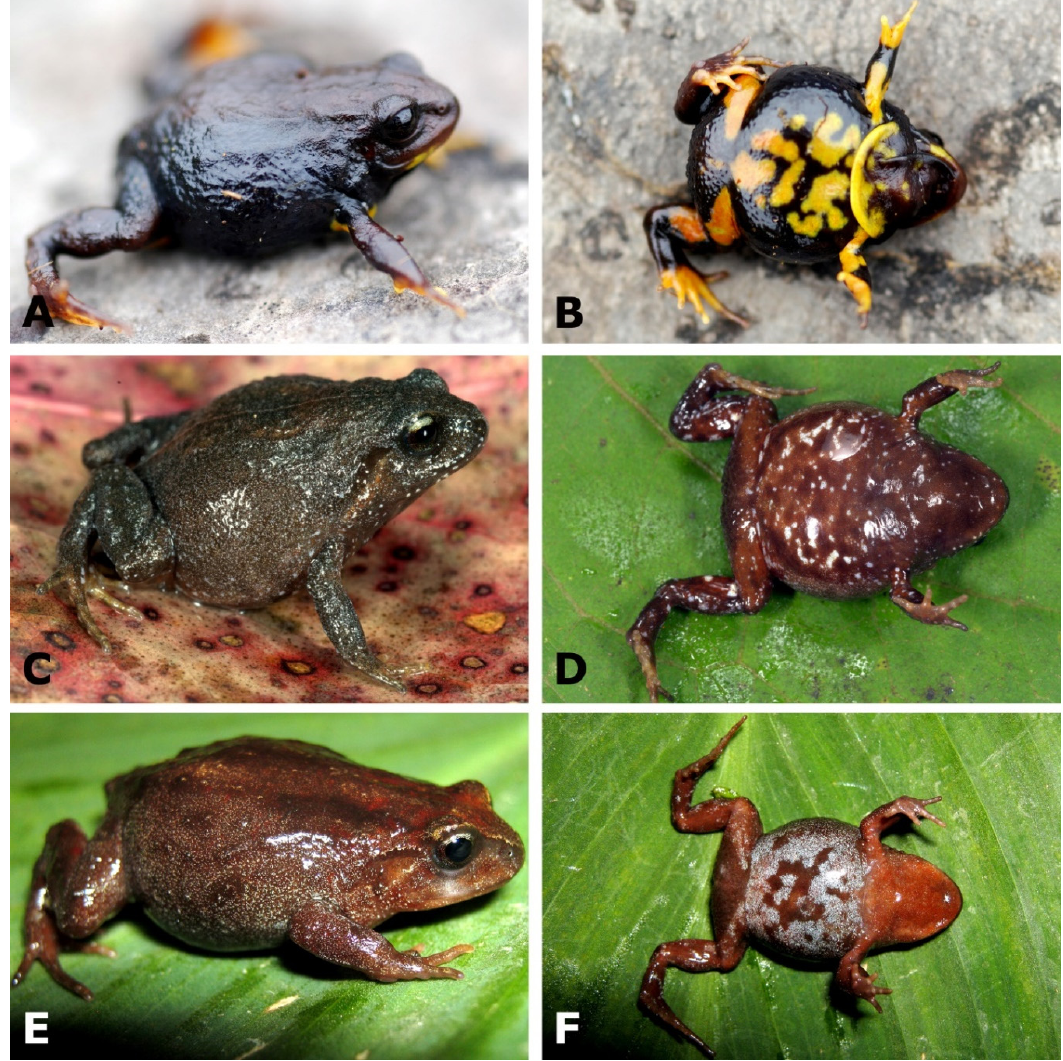
Figure 1. Holotypes of species of Qosqophryne gen. n. in dorsolateral and ventral views: ( A, B ) Q. flammiventris (MUSM 27613; SVL 19.8 mm): ( C, D ) Q. gymnotis (MUSM 25543; SVL 18.4 mm); ( E, F ) Q. mancoinca (MUBI 11152; SVL 26.5 mm). Photographs by E. Lehr (A, B), A. Catenazzi (C, D) and L. Mamani (E, F).